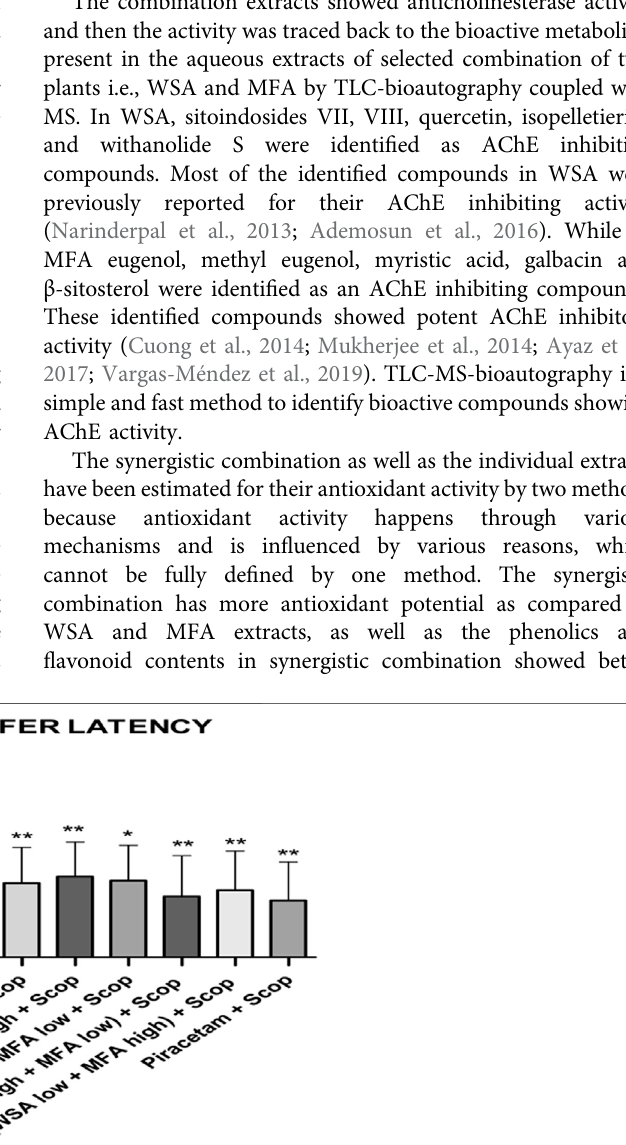
Frontiers in Pharmacology |